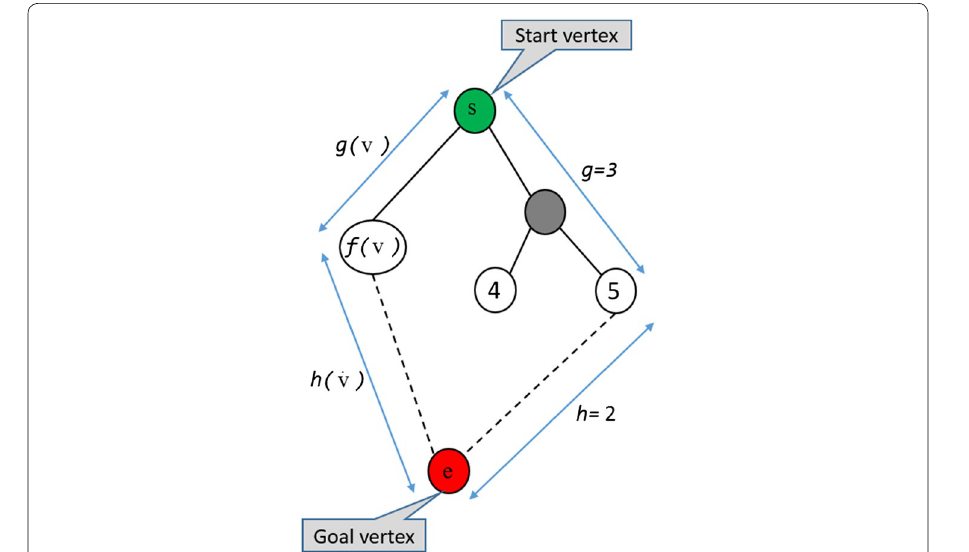
Fig. 2 Vertex evaluation with A*